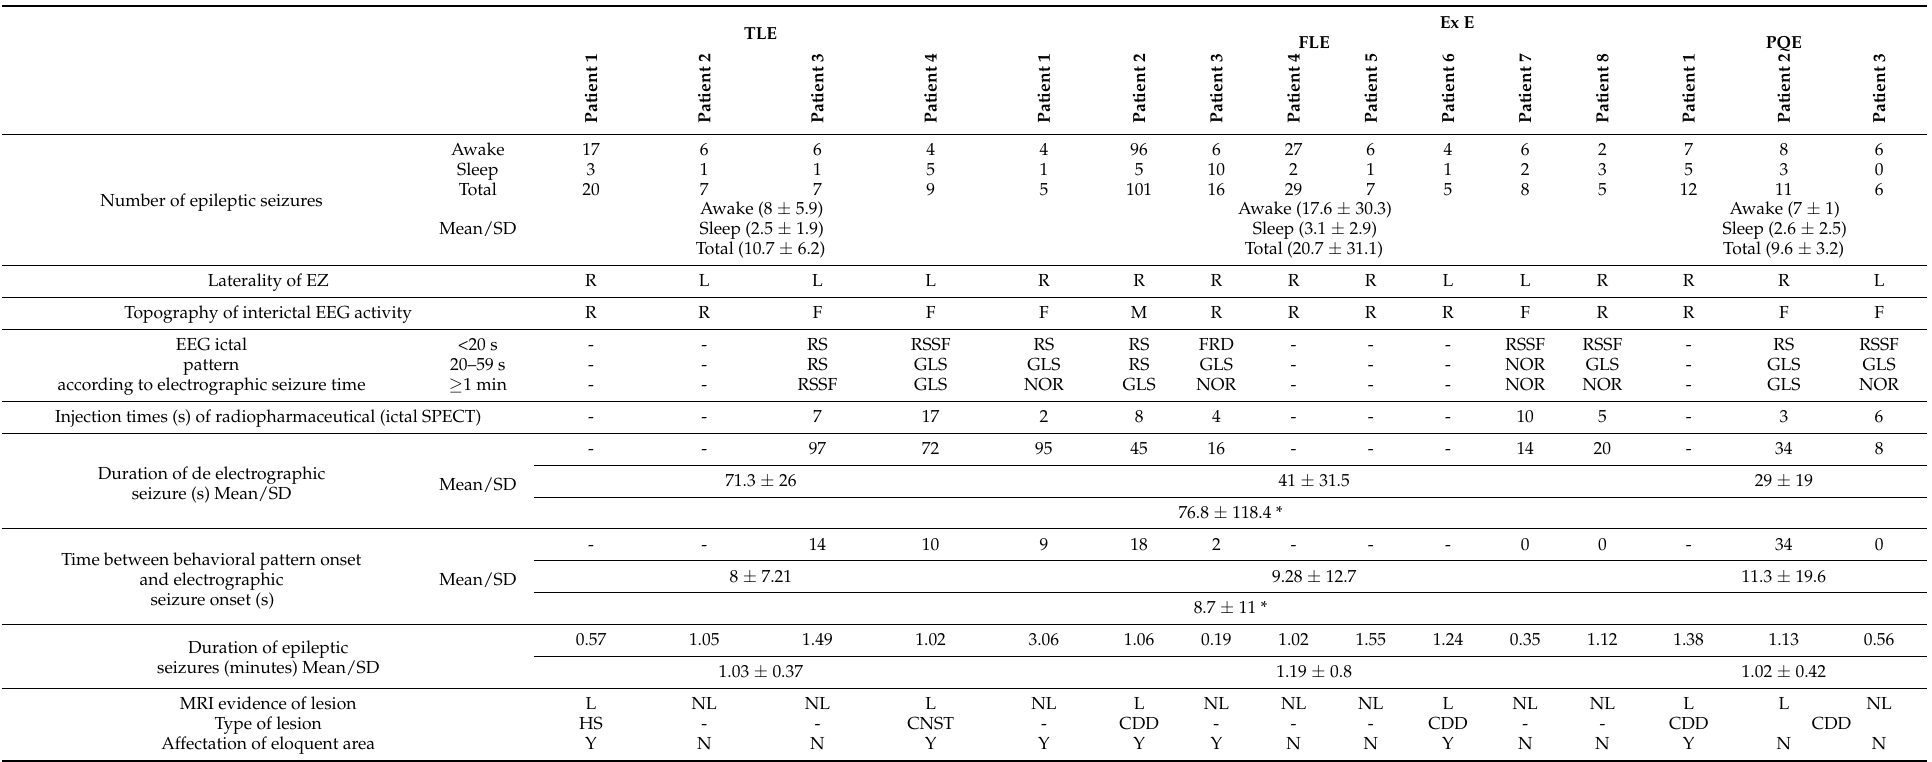
Table 2. Electroclinical and imagenological